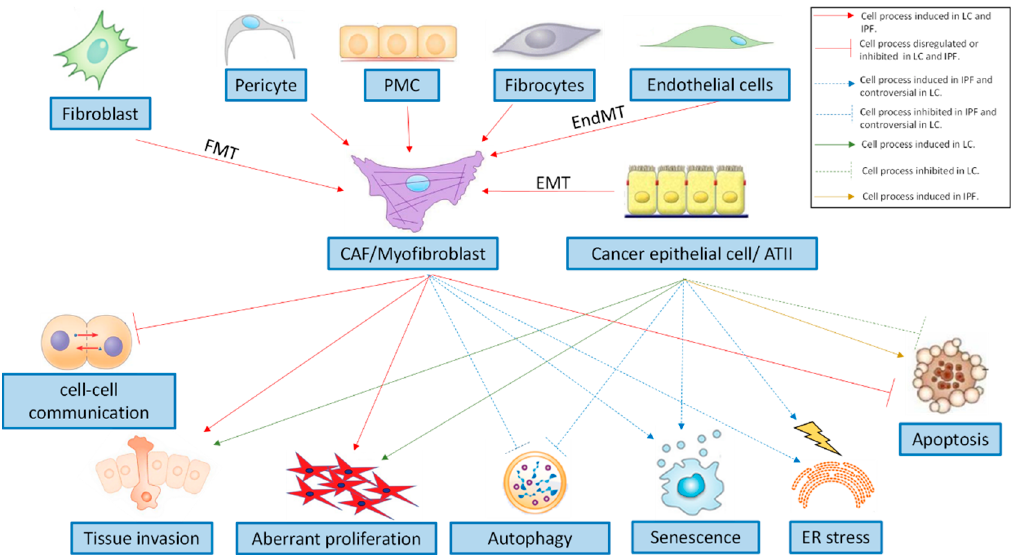
Figure 1. Cell types and cellular processes involved in lung cancer (LC) and idiopathic pulmonary fibrosis (IPF). Lung resident fibroblasts, pericytes, pleural mesothelial cells (PMC), circulating fibrocytes, vascular endothelial cells, and epithelial cells (Alveolar type II cells (ATII) in IPF and cancer epithelial cells in LC) are transformed to IPF myofibroblast or mesenchymal phenotype and cancer-associated fibroblasts (CAFs). Myofibroblasts and cancer cells are characterized by altered cell-cell communication, migration properties, and tissue invasion through basement membranes and the extracellular matrix. IPF myofibroblasts and ATII cells acquire senescent identities, but the presence of this phenotype is controversial in LC. Otherwise, endoplasmic reticulum (ER) stress is induced in IPF, while autophagy is defective in IPF. However, the function of both processes is controversial in LC. Finally, apoptosis is induced in ATII cells, but IPF myofibroblasts and cancer cells evade apoptosis.